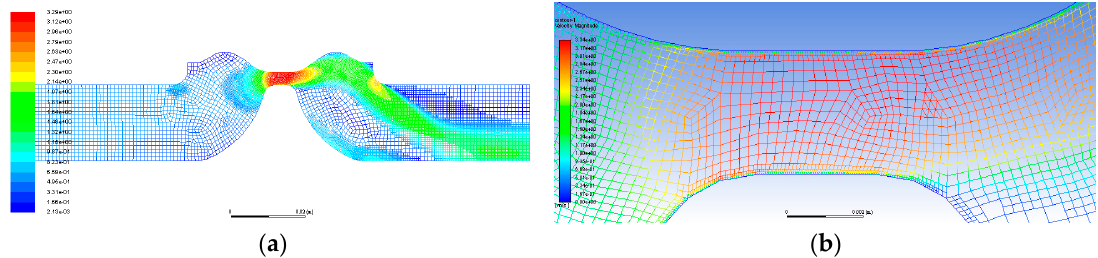
Figure 9. Cloud Map Display of Velocity Field at Different Openings shows that as the valve opening decreases, the velocity gradient increases. ( a ) for 40% opening; ( b ) for 30% opening; ( c ) for 20% opening; ( d ) for 10% opening.